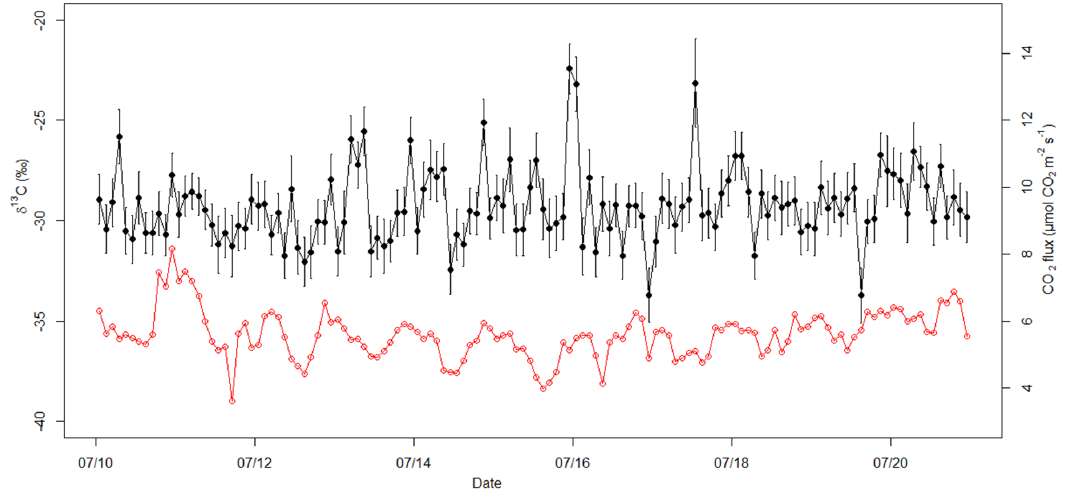
Figure 5. Example of 10 days of continuous, bi-hourly closed-chamber measurements from 10 July to 21 July for an intact soil plot. Both the δ 13 C of the CO 2 fluxes determined by Keeling plots (black points and line) and the CO 2 fluxes (red circles and line) are shown. Error bars on δ 13 C values show ± standard deviation of the intercept from the linear Keeling plot regression.